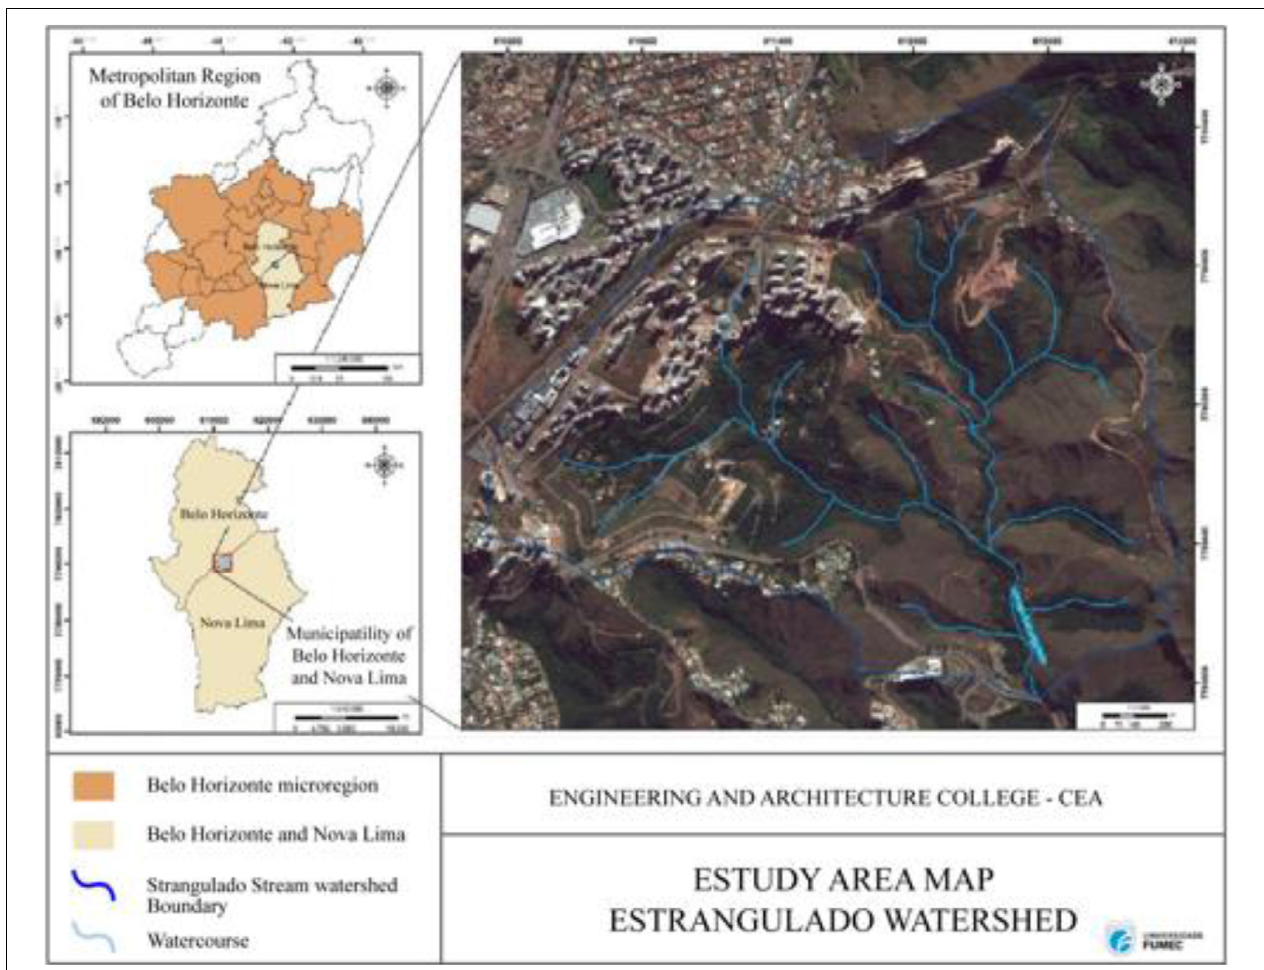
FIGURE 1 | Location of the “Estrangulado” stream basin, Nova Lima, MG, Brazil. Source: Vieira and Almeida,